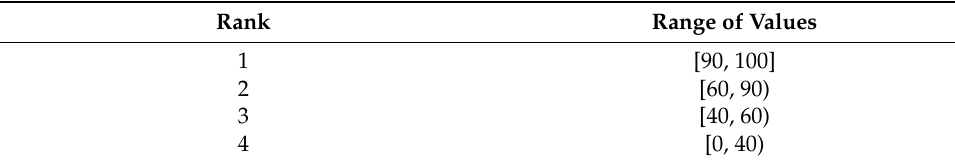
Table 3. Membership degree of qualitative indicators.